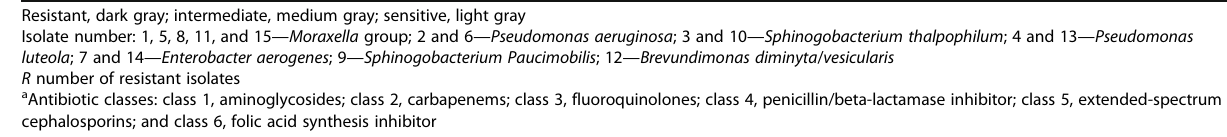
Resistant, dark gray; intermediate, medium gray; sensitive, light gray Isolate number: 1, 5, 8, 11, and 15 — Moraxella group; 2 and 6 — Pseudomonas aeruginosa ; 3 and 10 — Sphinogobacterium thalpophilum ; 4 and 13 —